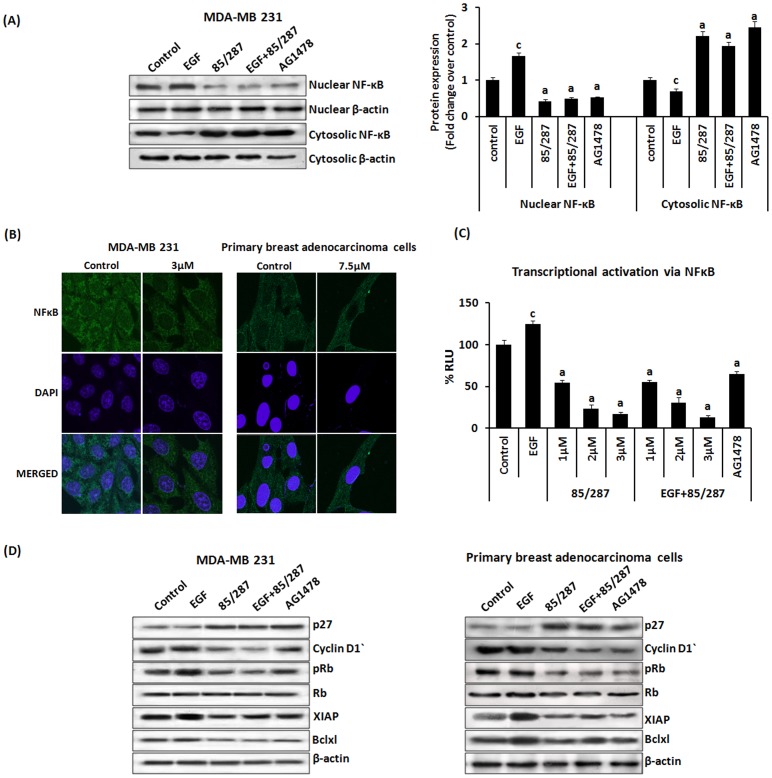
Effect of compound on downstream effectors of NF-κB and FOXO-3a.(A) Western blot analysis to see the nuclear and cytosolic expression of NF-κB in MDA-MB 231 cells. Cells were treated as shown in the figure for 48h. Nuclear and cytosolic proteins were extracted following manufacturer’s instructions and subjected for immunoblotting using anti-NF-κB antibody. Representative blots are shown in the left panel and densitometric quantitation of protein expression levels are shown as fold changes in the right panel. Results are expressed as mean ± SEM, n = 3. p values are a-p<0.001, b<0.01, c-p<0.05 and d-p>0.05 vs. control. (B) Confocal microscopy to demonstrate the effect of compound on localization pattern of NFκB (p65). MDA-MB 231 and primary breast cancer cells were treated with vehicle or indicated concentration of compound for 24 hrs. Cells were fixed, permeabilized, incubated with NFκB antibody for overnight, and incubated with FITC-conjugated anti-rabbit antibody for 1 h. The preparations were washed and counterstained with DAPI and images were captured at 63X using Carl Zeiss LSM 510 META microscope. Representative micrographs demonstrating the subcellular distribution of NFκB are shown. (C) Transcriptional activation of the NF-κB promoter in transiently transfected MDA-MB 231 cells in response to compound either alone or in the presence of 100 ng/ml EGF. MDA-MB 231 cells were transfected with pNF-κB-Luc reporter plasmids and incubated with various concentrations of CDRI-85/287 for 24h. pRL-luc plasmid was used as internal control. Results are described as % of normalized relative luciferase unit (RLU). Results are expressed as mean ± SEM, n = 3. p values are a-p<0.001, b-p<0.01, c-p<0.05 and d-p>0.05 vs. control and e-p<0.001, f-p<0.01, g-p<0.05 and h-p>0.05 vs. EGF. (D) Western blot analysis for the expression of cell cycle regulatory and anti-apoptotic proteins (Bclxl and XIAP) in MDA-MB 231 (left panel) and primary breast cancer cells (right panel). Cells were treated with the indicated concentrations of compound for 48h and 30 µg whole cell lysate in each lane was probed for the expression of different proteins using specific antibodies. β-actin was used as a control to correct for loading. Representative blots are shown. Densitometric analysis of bands is shown in Fig. S2.